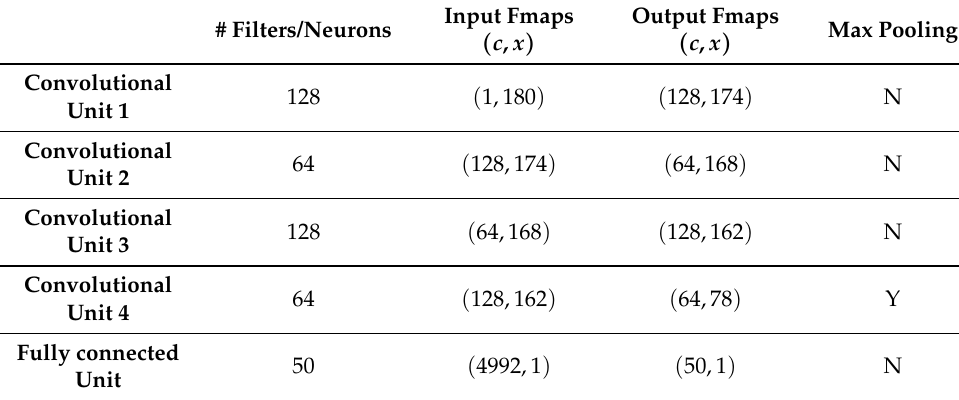
Table 2. ECG-ID-BNet architecture. Extracted from [6]. Input # Filters/Neurons